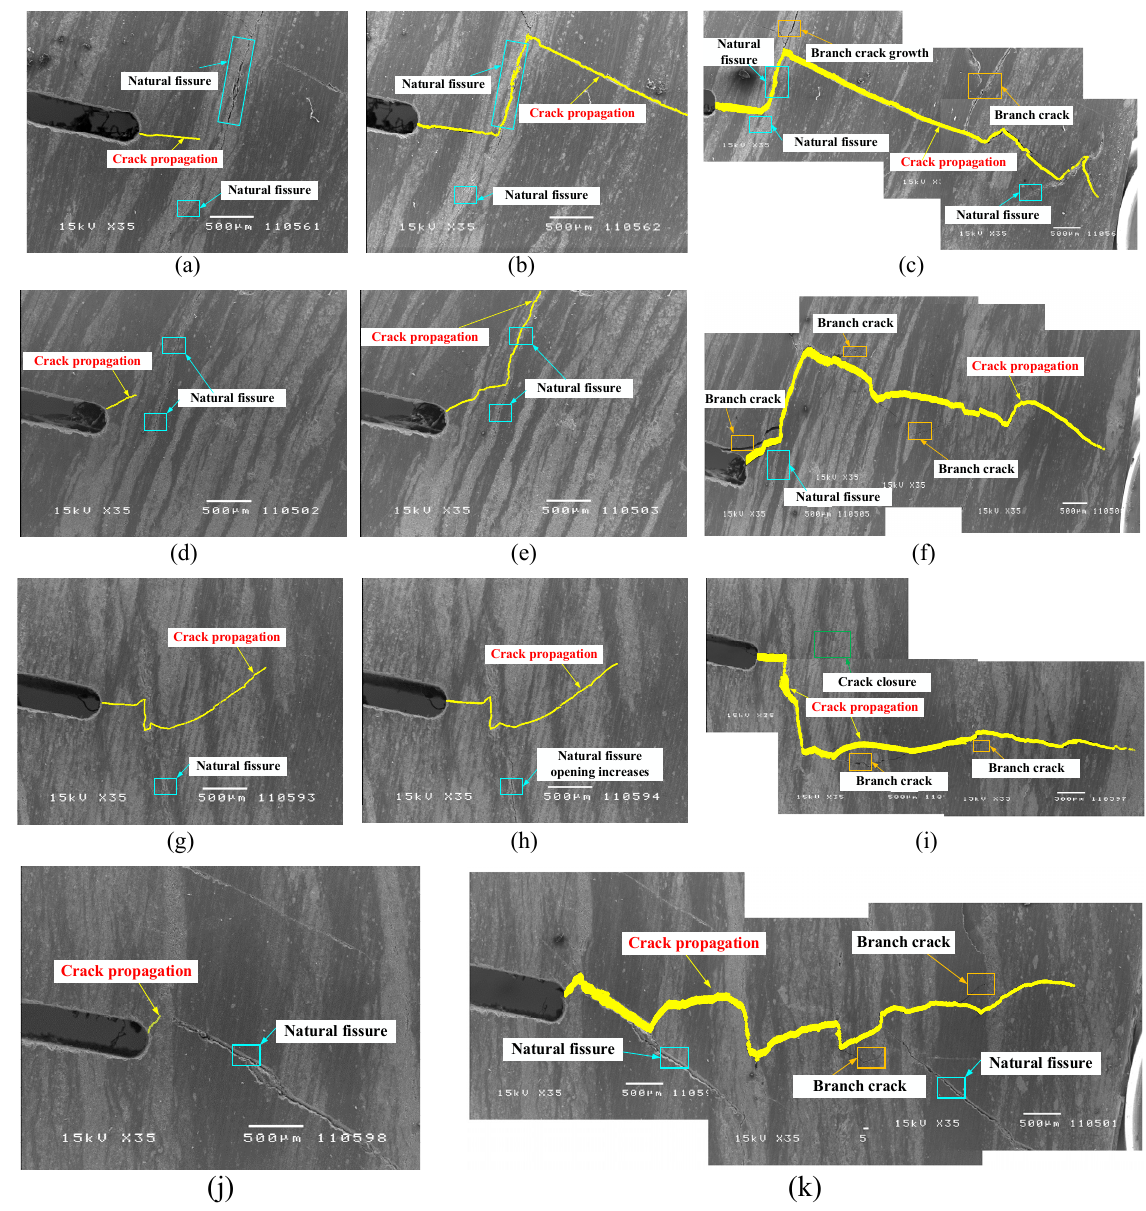
Figure 8. Crack propagation path under different loads. ( a ) XZY-1 (63.8 N); ( b ) XZY-1 (73.4 N); ( c ) XZY-1 (fractured); ( d ) XZY-2 (59.8 N); ( e ) XZY-2 (78.1 N); ( f ) XZY-2 (fractured); ( g ) XZY-3 (53.6 N); ( h ) XZY-3 (67.7 N); ( i ) XZY-3 (fractured); ( j ) XZY-4 (53.5 N); ( k ) XZY-4 (fractured).